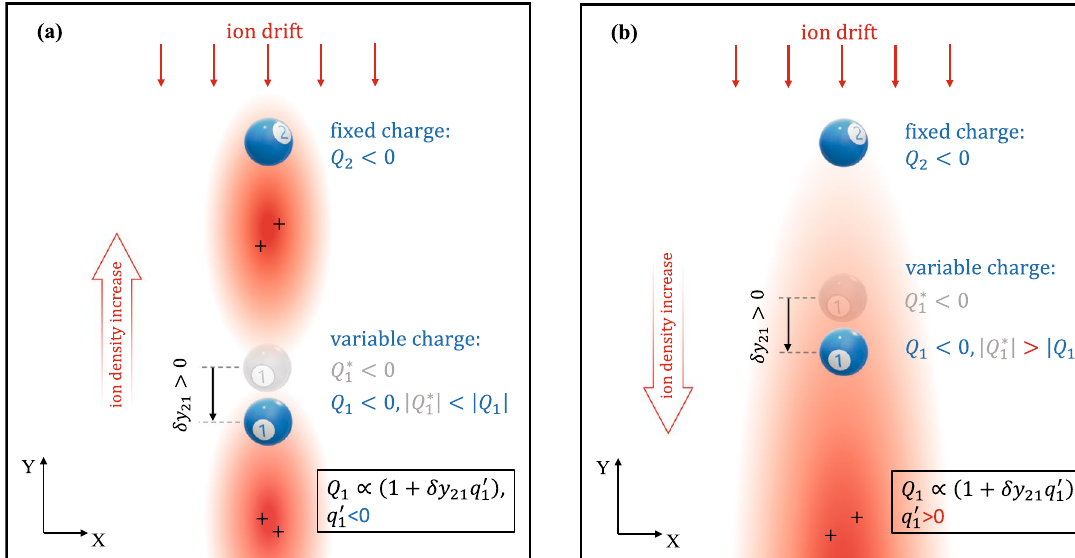
Figure 8. Changing the lower particle charge depending on its position relative to the ion wake of the upper particle: between particles ( a ) or behind both ( b ).